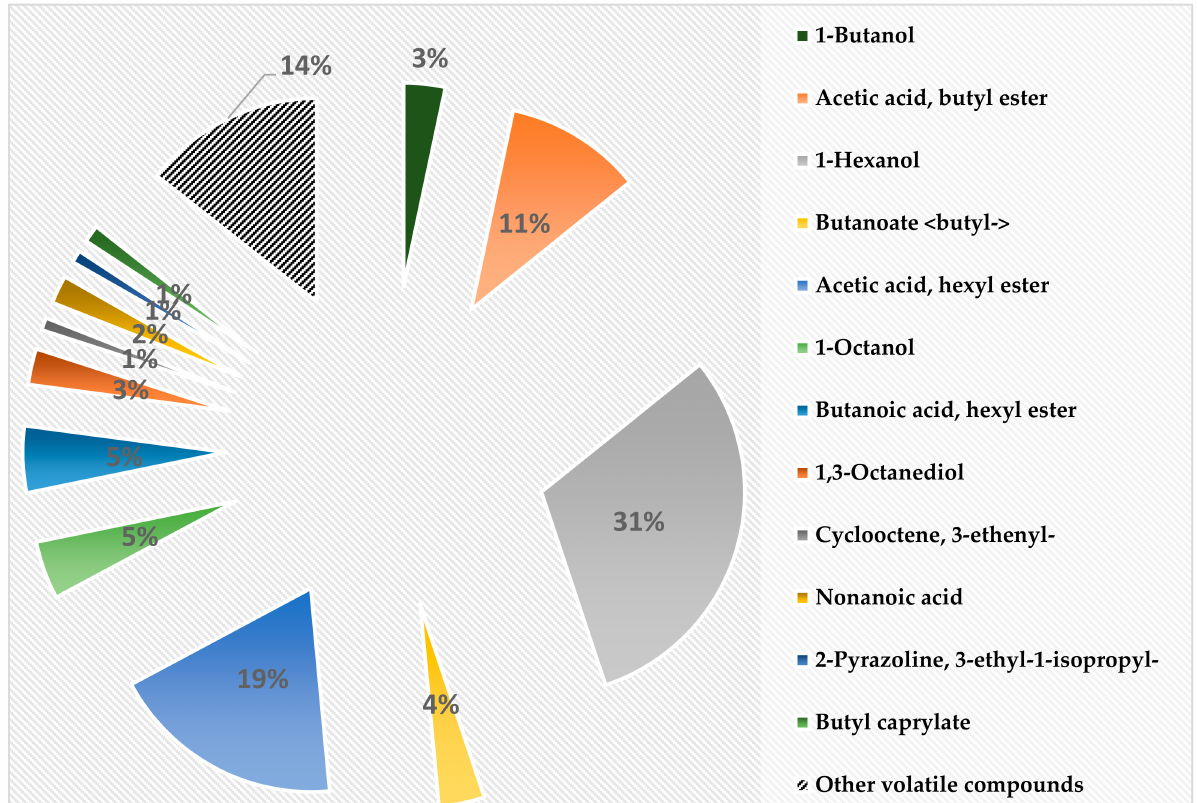
Figure 2. Volatile compound profile (% from the total volatile compounds) of non-fermented frozen apple